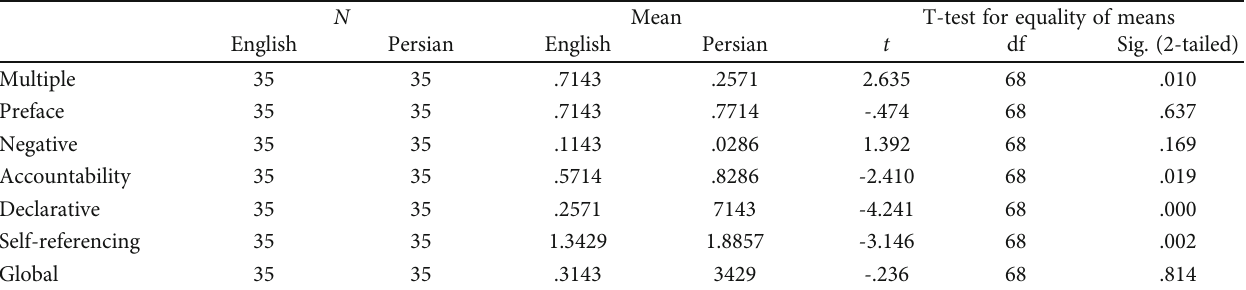
Table 7: Independent samples T-test for adversarialness in Persian and English press conferences.